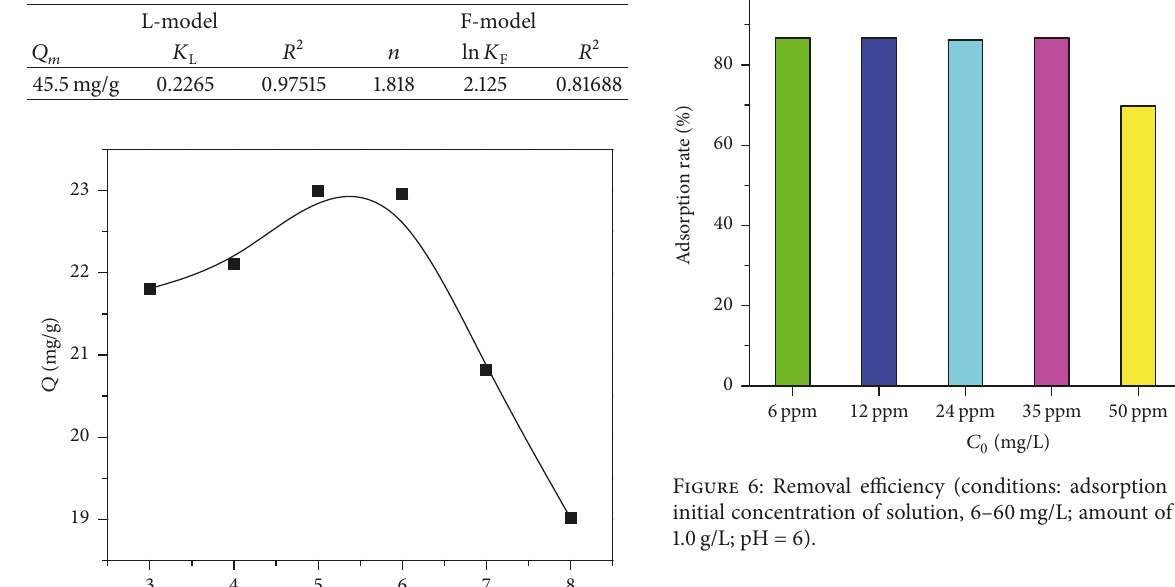
Table 1: Parameters for the Langmuir and Freundlich models.